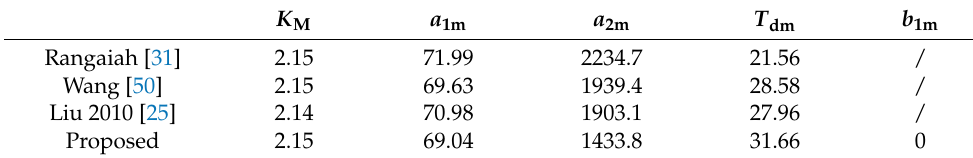
Table 8. The estimated model parameters for the process G P4 .